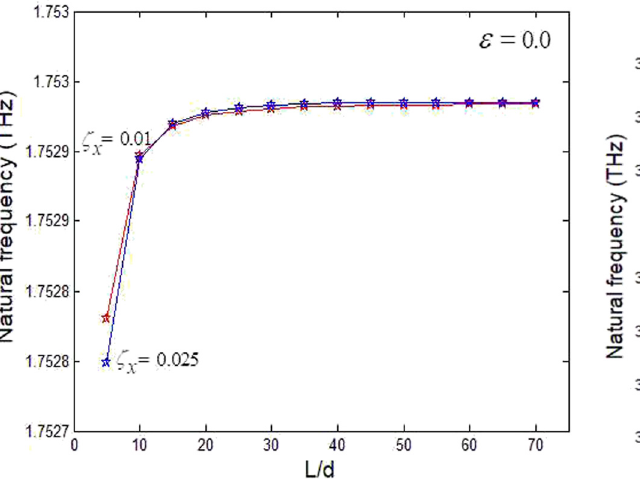
Figure 6: Variations in the natural frequency of irregular ( ε = 0.28 ) single - walled carbon nanotube against aspect ratio ( L / d ) under initial stresses ( ζ = 0.01, 0.025 ) .